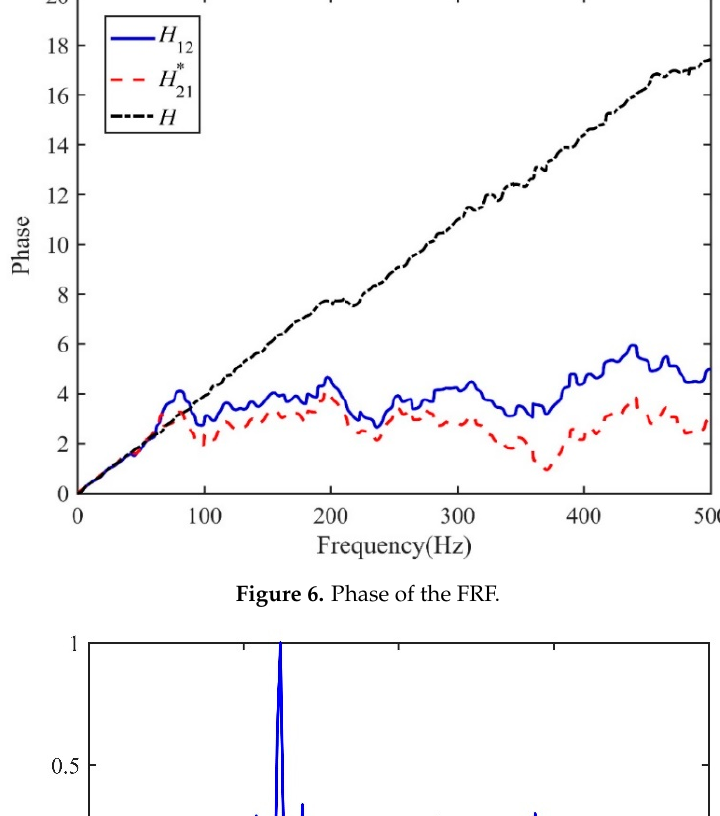
Figure 5. IRFs given by the conventional LMS adaptive method.